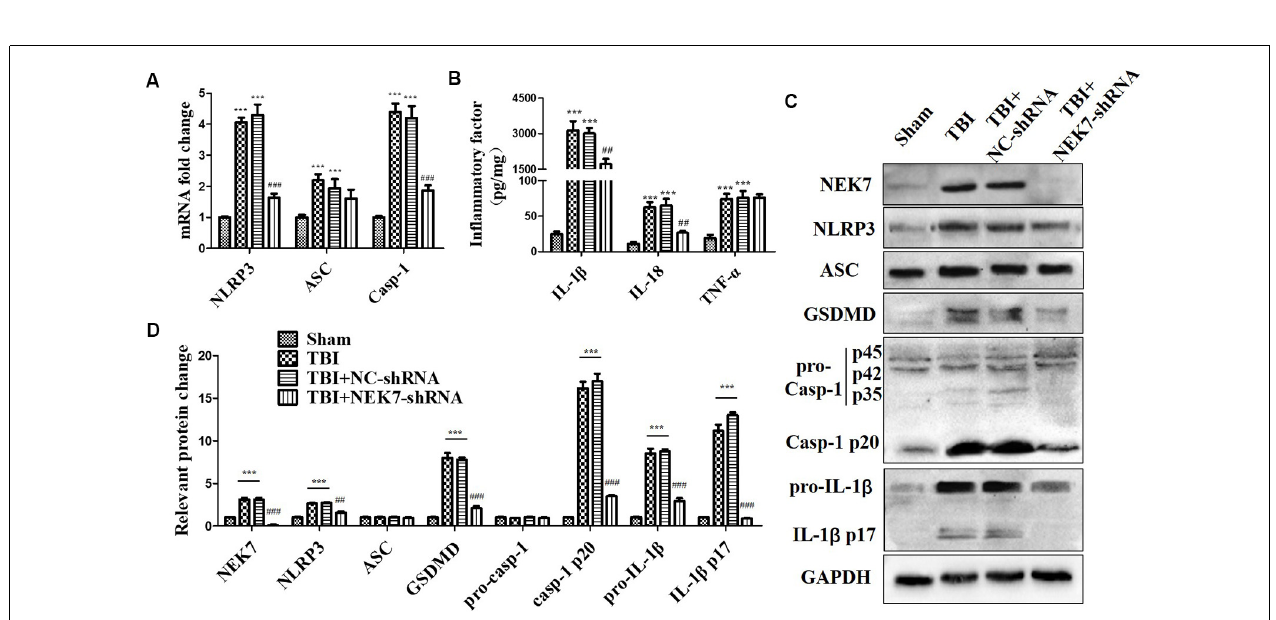
FIGURE 4 | NEK7 knock-down suppresses NLRP3 inflammasome activation in vivo . At 48 h after TBI, qRT-PCR analysis of NLRP3, ASC, and caspase-1 mRNA level in cortical tissue (A) ; enzyme-linked immunosorbent assay (ELISA) analysis of IL-1 β , IL-18, and TNF- α level in cortex tissue (B) ; and western blot (WB) analysis of NLRP3, ASC, gasdermin D (GSDMD), caspase-1, and IL-1 β protein level in cortical tissue (C) . (D) Statistical analysis of NLRP3, ASC, GSDMD, caspase-1, and IL-1 β protein level in cortical tissue. Data are represented as the means ± SEM, n = 8. ∗∗∗ p < 0.001, vs. sham. ## p < 0.01, ### p < 0.001, vs. TBI + negative control